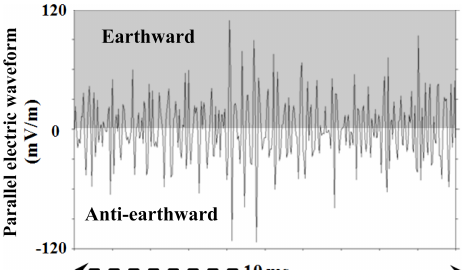
Figure 2. A 10ms sequence of the fluctuations observed in the 32kHz quasi-parallel electric field waveform. The data were acquired on the high-potential side of the recorded DL at ∼ 06:44:45UT. They characterize the presence of EHs which have time spans of about 150µs with amplitudes of ∼ 120mVm − 1 . All the EHs have a positive then a negative polarity indicating that they are travelling